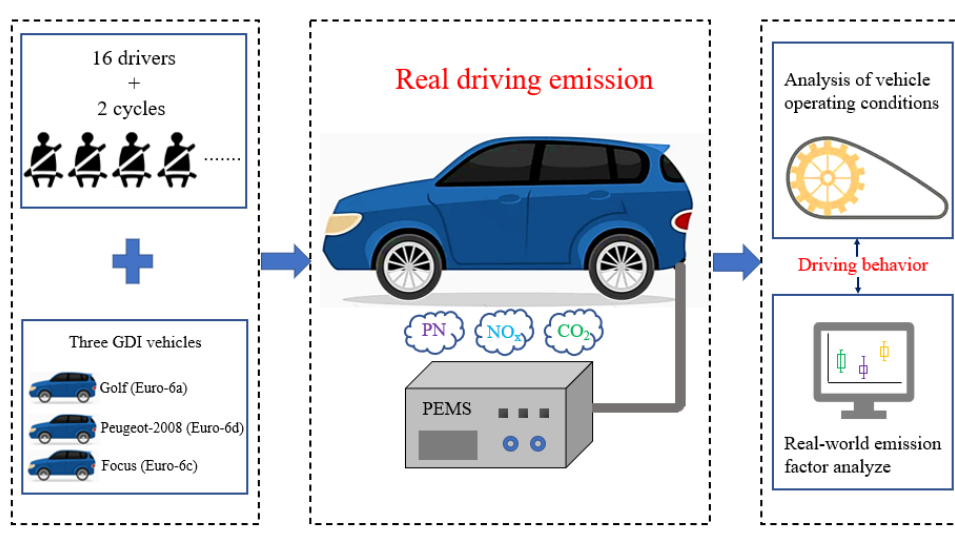
Figure 1. Test Figure 1. Test scheme.